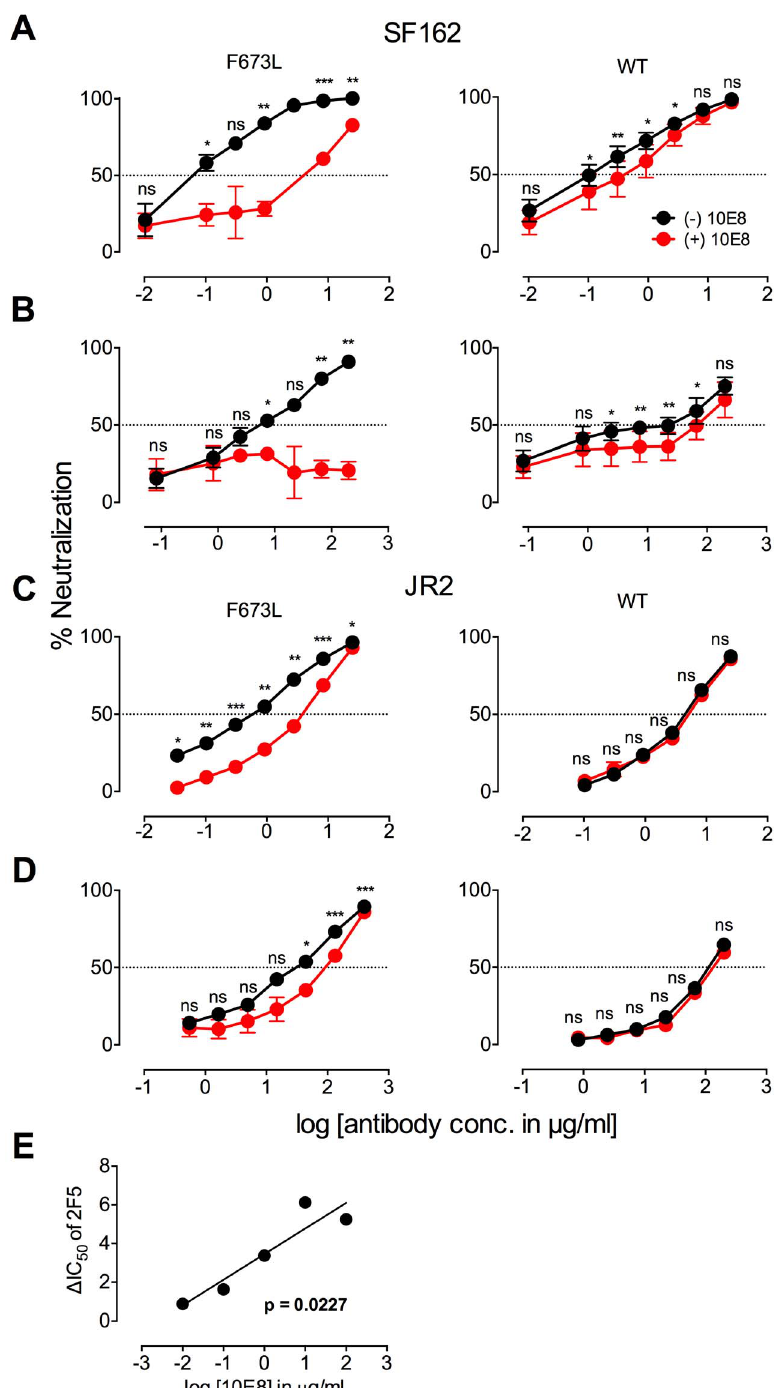
Figure 2. Presence of 10E8 diminishes neutralization sensitivity of HIV-1 to 2F5 and Z13e1. The maximum infectivity of virus in presence or absence of 10E8 was normalized to 100% for mutant F673L (left panels) and wild type HIV-1 (right panels); 10E8 was held constant at 10 m g/ml and the IC 50 for F673L mutants and wild type viruses, respectively. The 10E8 resistant fraction of viral infectivity was assayed against ( A and C ) 2F5 and ( B and D ) Z13e1. Neutralization curves in black and red indicate absence and presence of 10E8, respectively, for ( A and B ) SF162 and ( C and D ) JR-FL. Experiments were performed in duplicate in at least two independent experiments, except for wild type SF162 that was tested in four independent experiments (n=4). Statistical significance was determined for each pair of points along the dose response curves (in presence or absence of 10E8) using an unpaired t test and p-values were corrected using the Sidak-Bonferroni method for multiple comparisons. Symbols above each pair of data points represent the p-values (*, p , 0.05; **, p , 0.01; ***, p , 0.001; ns, not significant). ( E ) Statistical significance of the change in IC 50 of 2F5 against JR2 F673L due to the presence of 10E8 was determined using linear regression analysis.